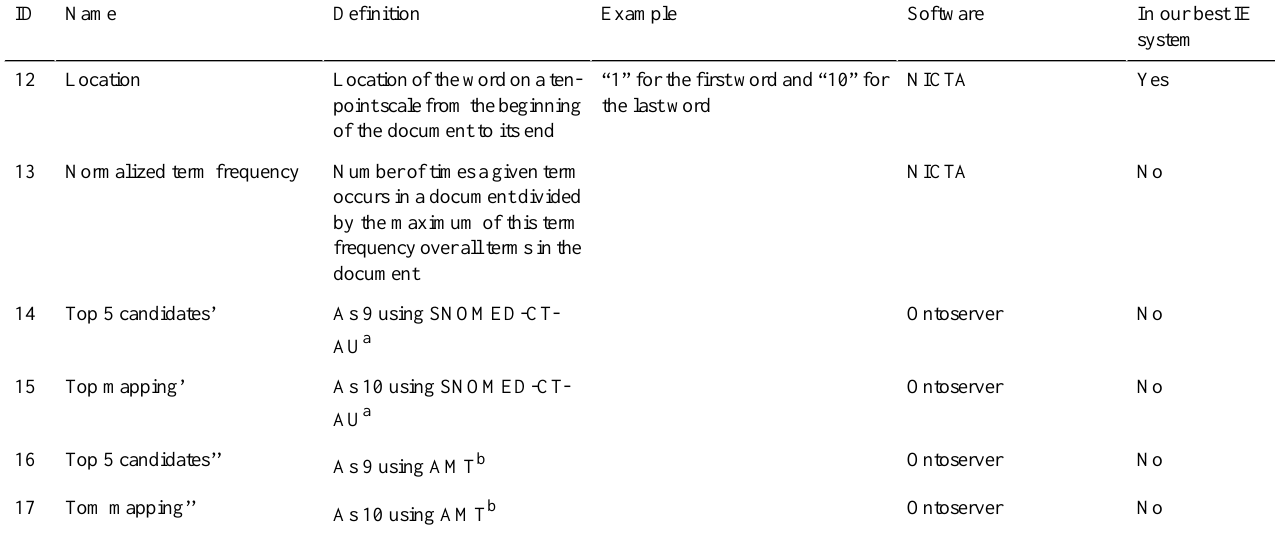
Table 3. Experimented feature types, statistical features.